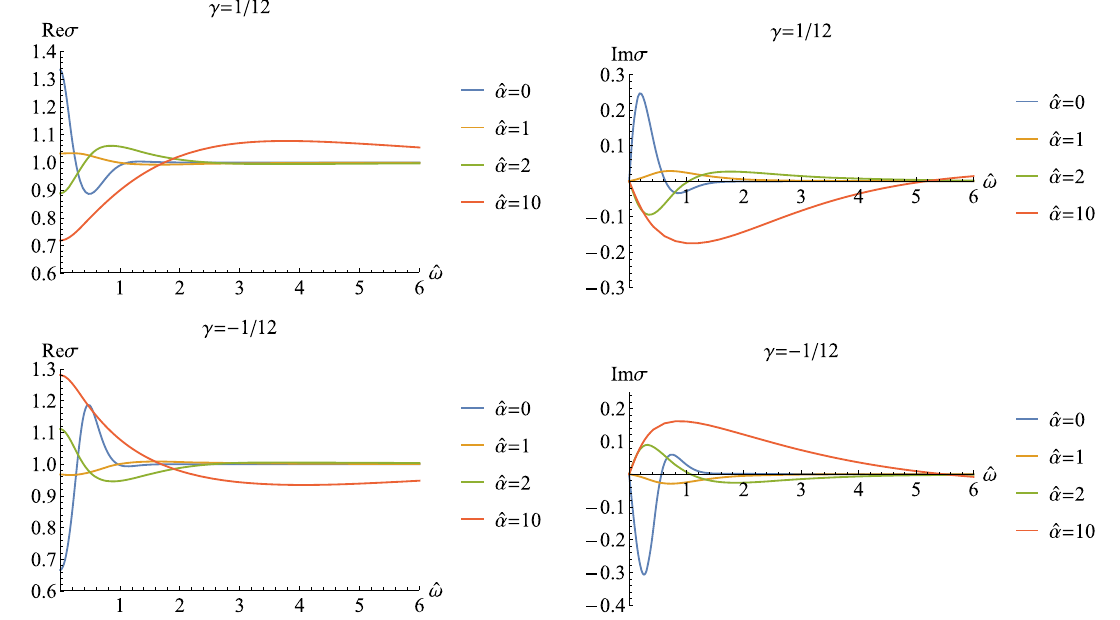
Fig. 1 The optical conductivity σ( ˆ ω) as the function of ˆ ω with different ˆ α for fixed β (the plots above is for γ = 1 / 12 and the one below for γ = − 1 / 12). (For interpretation of the references to color in this figure, the reader is referred to the web version of this paper)